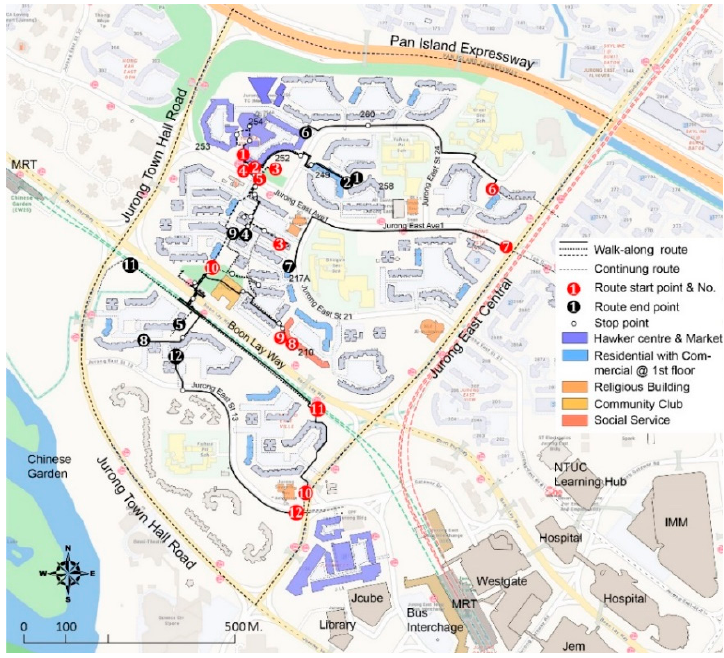
Figure 2. Mapping the walk-along interviews with 12 participants in Yuhua East.